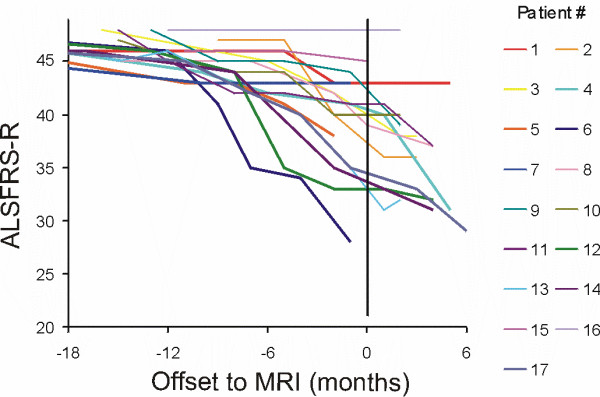
Course of ALSFRS-R score prior to MRI. On average, ALSFRS was 39.6 ± 5.6 around the time of the scan reflecting the ALS cohort was mildly affected by disease. Note that some patients had barely gone into rapid progression whereas others have remained stable at a high score.